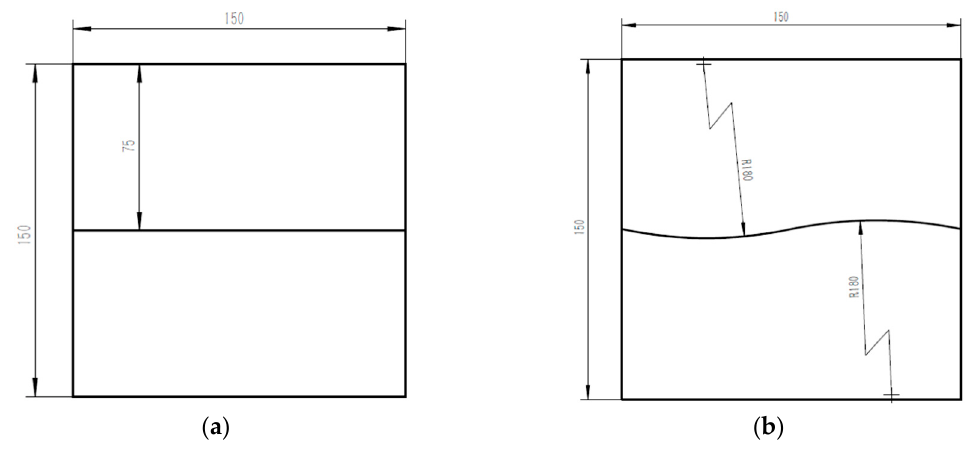
Figure 22. The CAD model of the workpiece samples. ( a ) A workpiece with the straight line path; ( b ) A workpiece with the S-curve